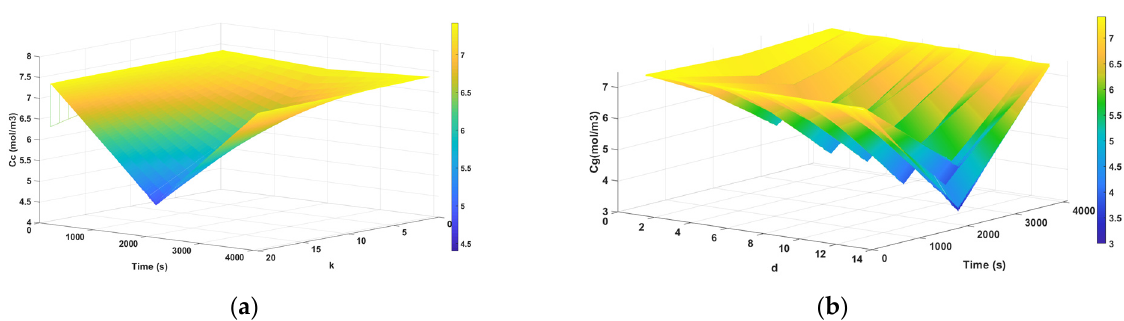
L (cid:2913) , t) = C (cid:2913)(cid:2924) (y (cid:2924) ,t) C (cid:2928)(cid:2915)(cid:2916) as a function of time and k . ( b ) Concen- Figure 9. ( a ) Concentration C (cid:2913) (y = (cid:2921) (cid:2895) h (cid:2914) , y = (cid:2921) L (cid:2913) ,t) = C (cid:2917)(cid:2924) (x (cid:2924) , y (cid:2924), , t)C (cid:2928)(cid:2915)(cid:2916) as a function of time and d , and two values of k tration C (cid:2917) (x = (cid:2914) (cid:16) (cid:17) (cid:16) (cid:17) (cid:2888) (cid:2895) = C gn centration C g x = d h d ,y = k L c , t x n ,y , t C ref as a function of time and d, and two = 0 and k = K = 20 . n, D K values of k =0 and k = K =